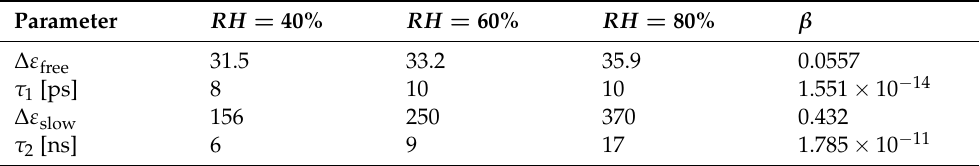
Table 1. Cole–Cole parameters from [21] at three hydration levels were used to approximate the SC hydration dependency. β lists the calculated scaling value resulting from the linear